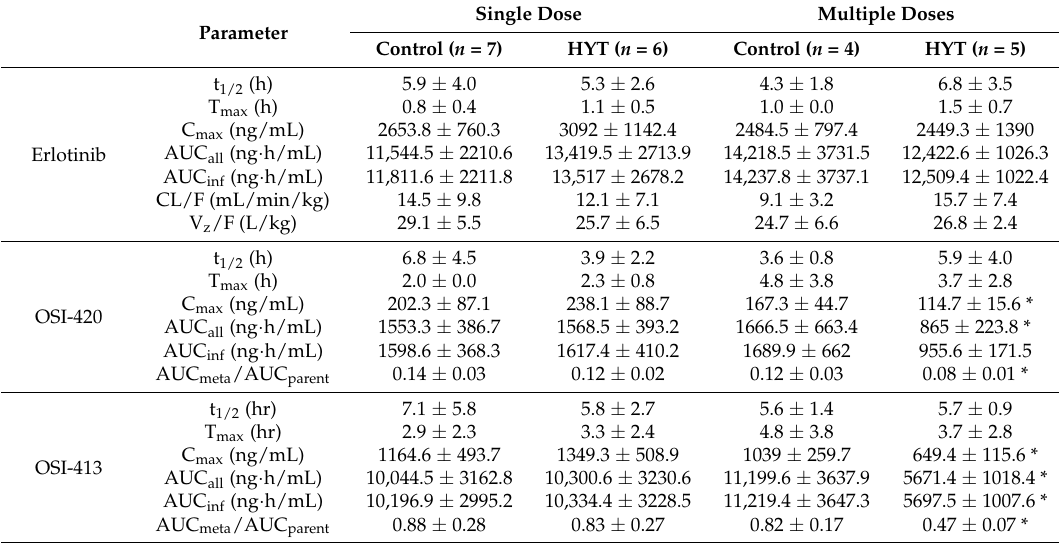
Table 2. Non-compartmental pharmacokinetic parameters of erlotinib, OSI-420, and OSI-413 following administration of the combination of anticancer agent; gemcitabine (i.v., 10 mg/kg) and erlotinib (p.o., 20 mg/kg) to rats pretreated with 1% CMC-Na (Control) or Hyangsayukgunja-tang (HYT) 1200 mg/kg as a single dose or multiple doses for 14